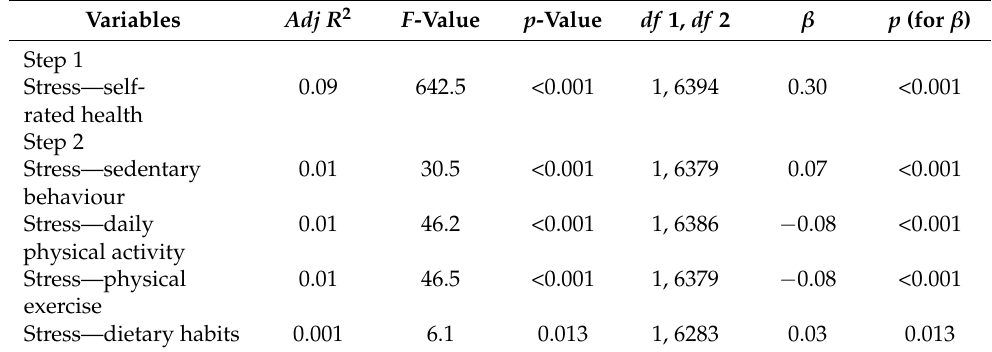
Table 3. Simple regression analyses for participants who did not report any of the requested diagnoses (steps 1 and 2).